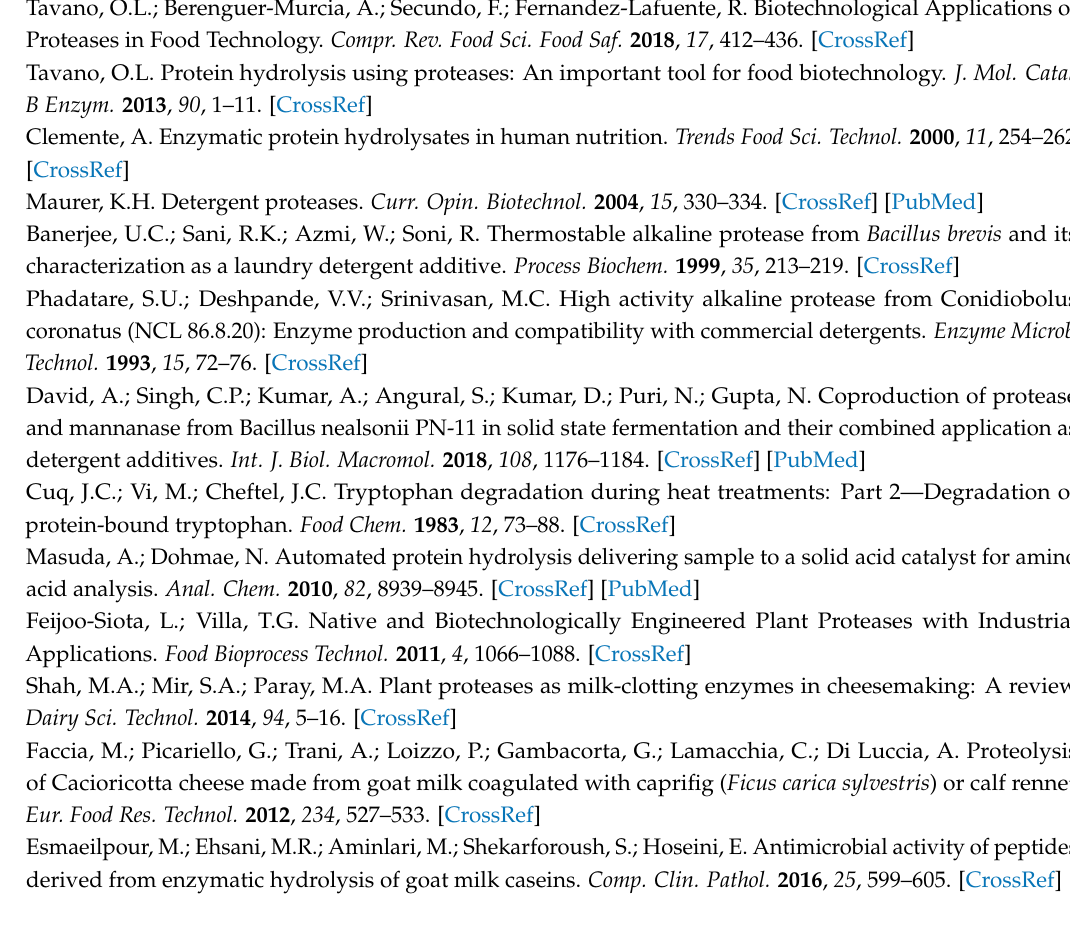
Figure S1: SDS PAGE of ficin extract (1 mg/ml). Lane 1 Molecular weight markers, Lane 2, 3, 4 different ficin extracts used in this